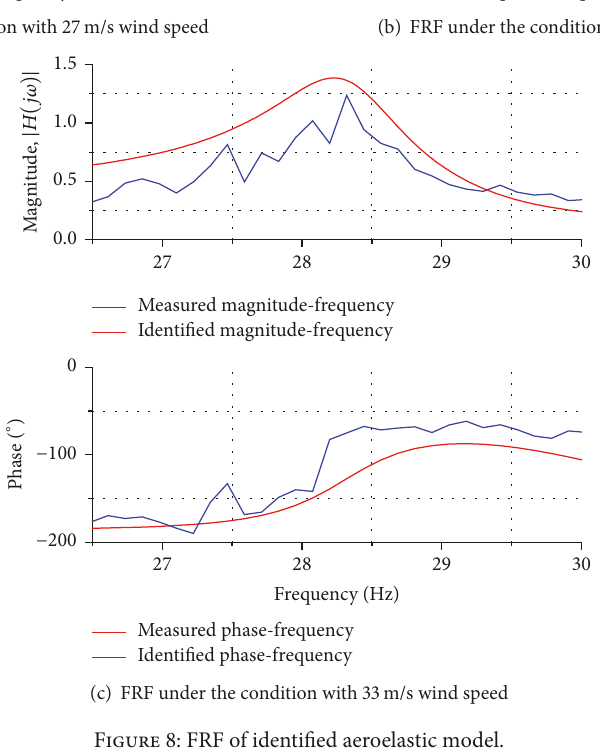
Figure 8: FRF of identified aeroelastic